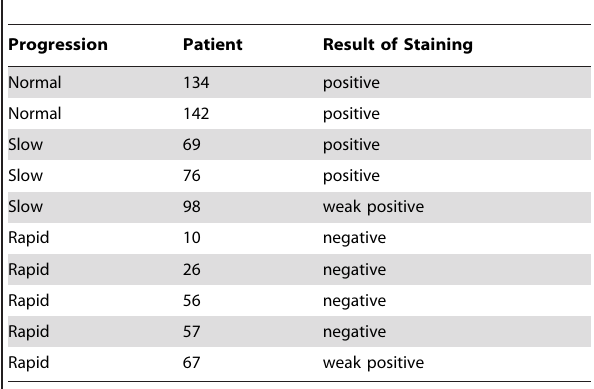
Table 5. Summary of semi-quantitative assessment of immunohistochemical staining for Argonaute2 (antibody dilution of 4 m g/ml) in normal, slow, and rapid IPF biopsies.